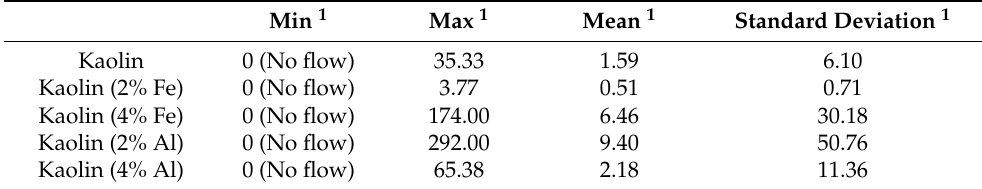
Table 1. Mass flow rate values of different clay samples.